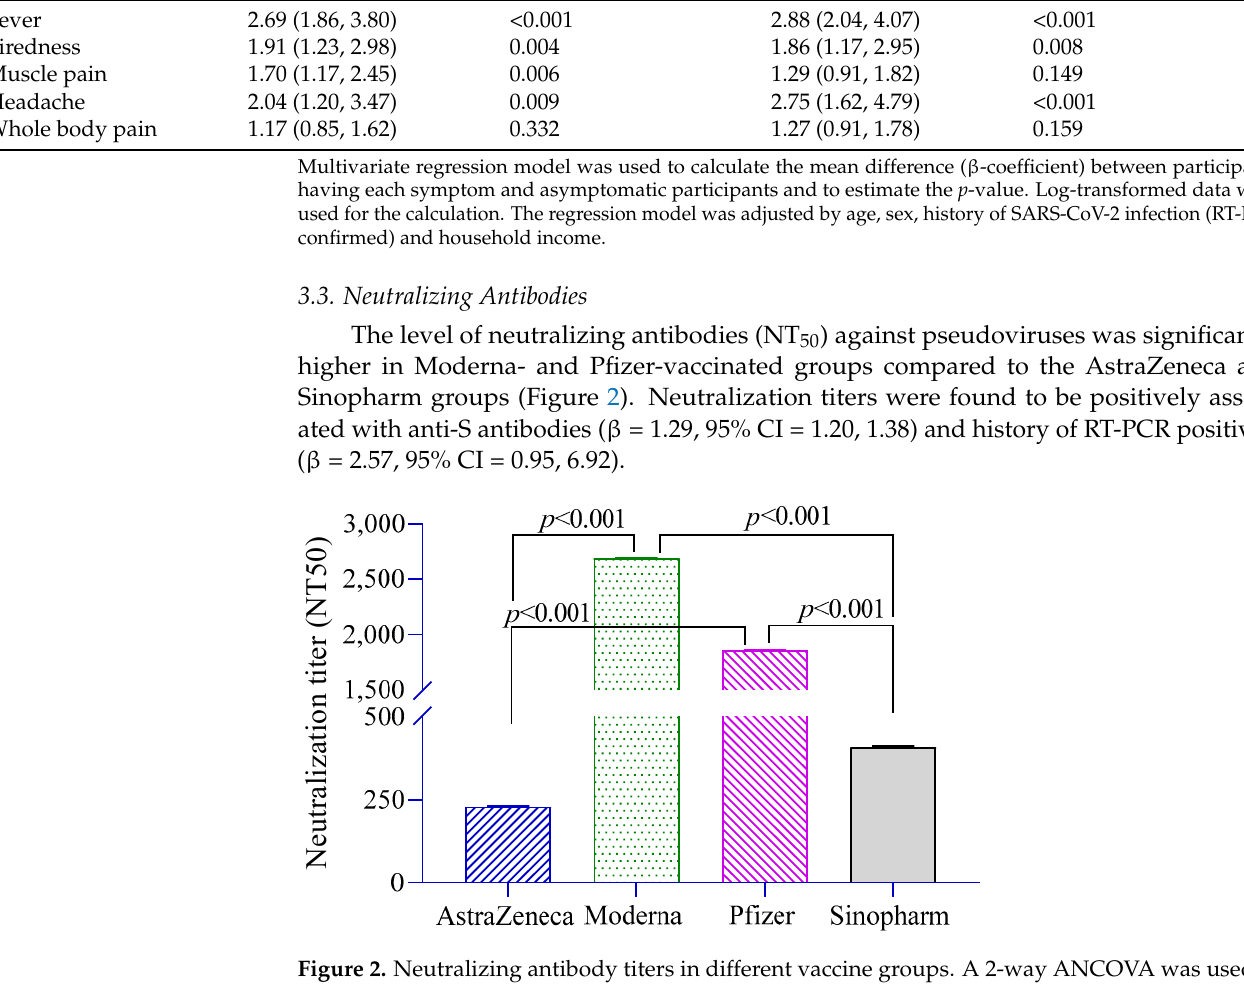
Figure 2. Neutralizing antibody titers in different vaccine groups. A 2-way ANCOVA was used to estimate the p -value, and the model was adjusted for age, sex, income and BMI.